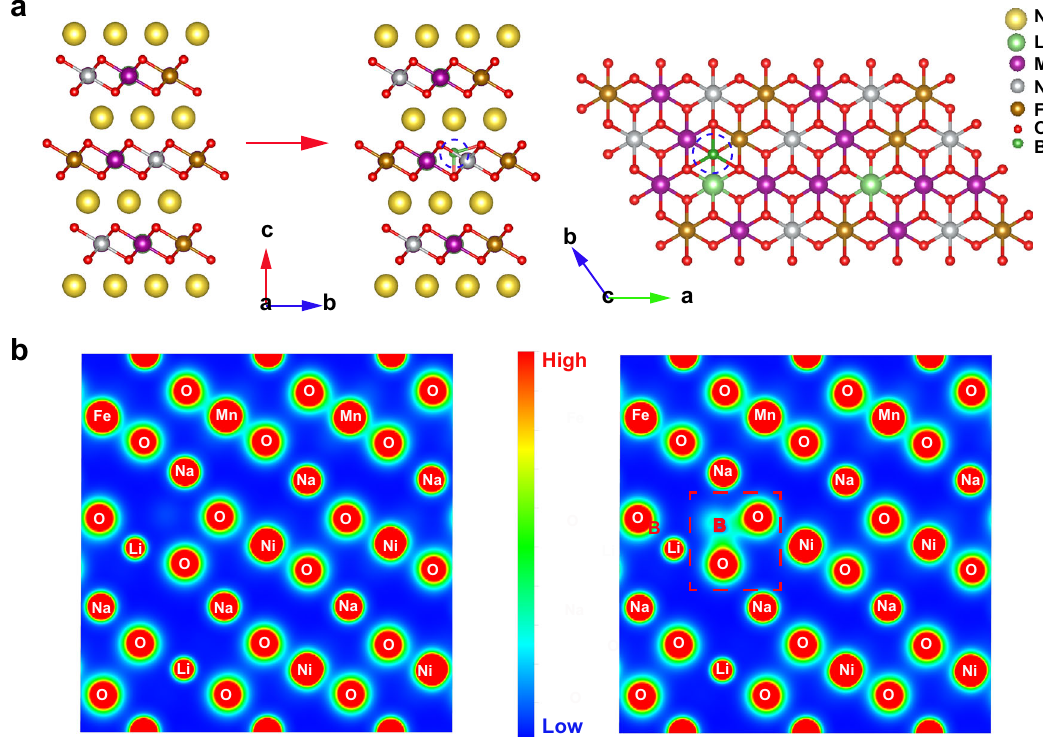
Fig. 2 Structure and charge density analysis. Schematic structures of NLNFM and NLNFMB ( a ). Contour maps of charge density on corresponding planes in NLNFM and NLNFMB ( b